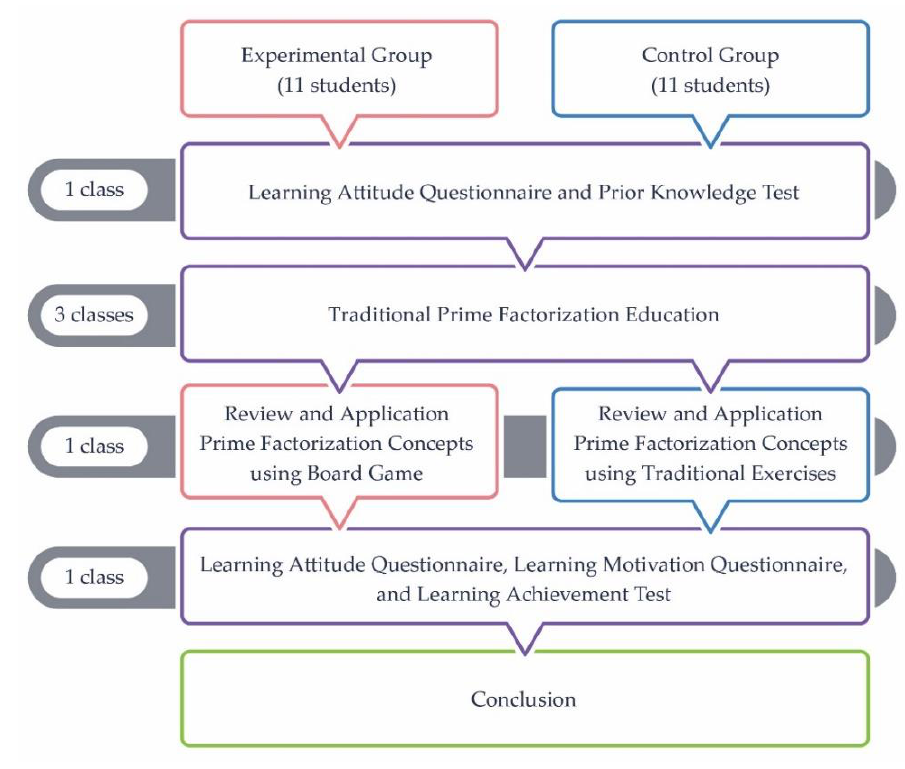
Figure 4. Experimental procedure.